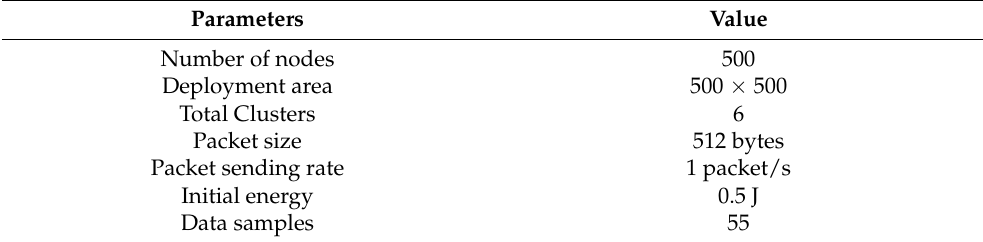
Table 1. Parameters for simulation